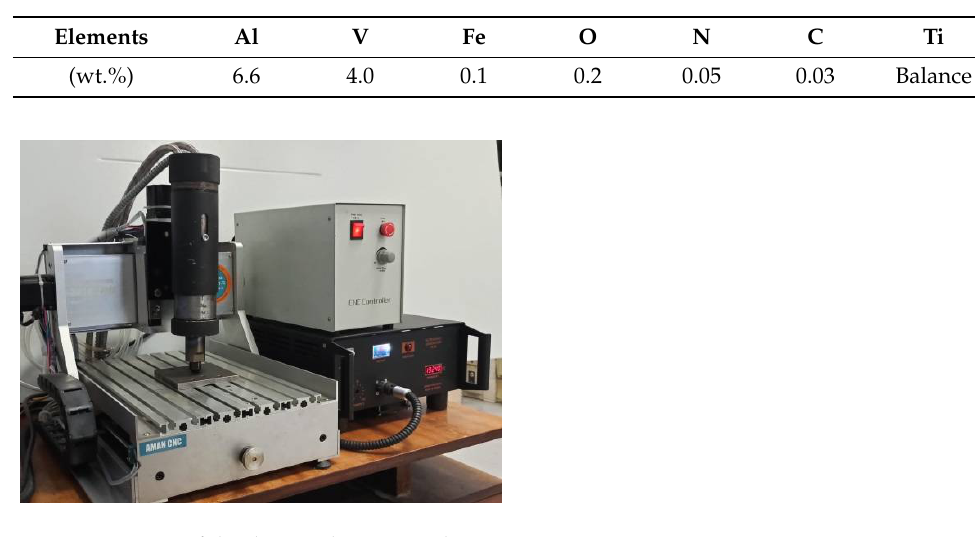
Table 1. Chemical composition of Ti-6Al-4V titanium alloy.